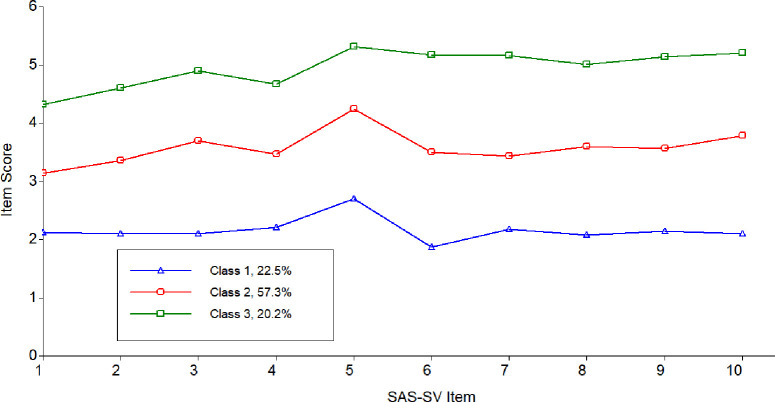
Latent classes from the three-class solution.